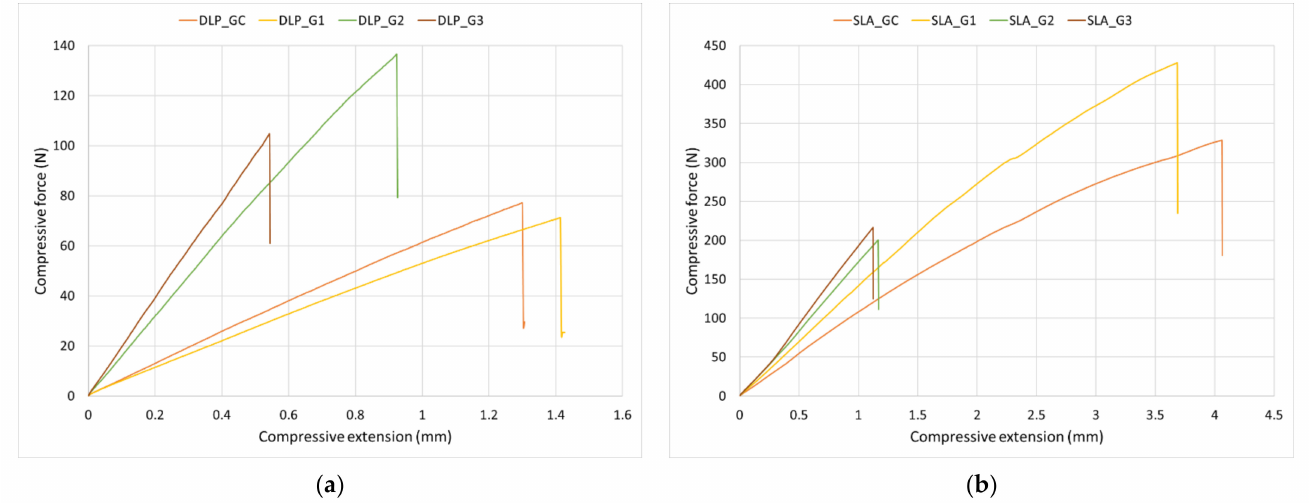
Figure 6. Compressive load–displacement curves: ( a ) surgical guides printed using the DLP method; ( b ) surgical guides printed using the SLA method.